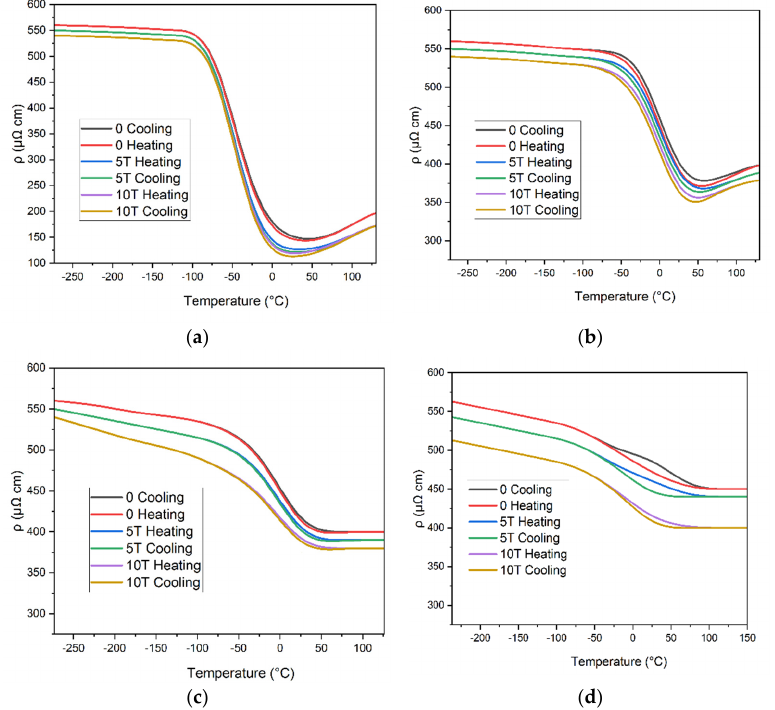
Figure 5. Electric transport property for Ni 50 − x Fe x Mn 30 Sn 20 − y In y where 1 ≤ x ≤ 4; 2 ≤ y ≤ 8 alloy and ( a ) x = 1, y = 2; ( b ) x = 2, y = 4; ( c ) x = 3, y = 6; and ( d ) x = 4, y =